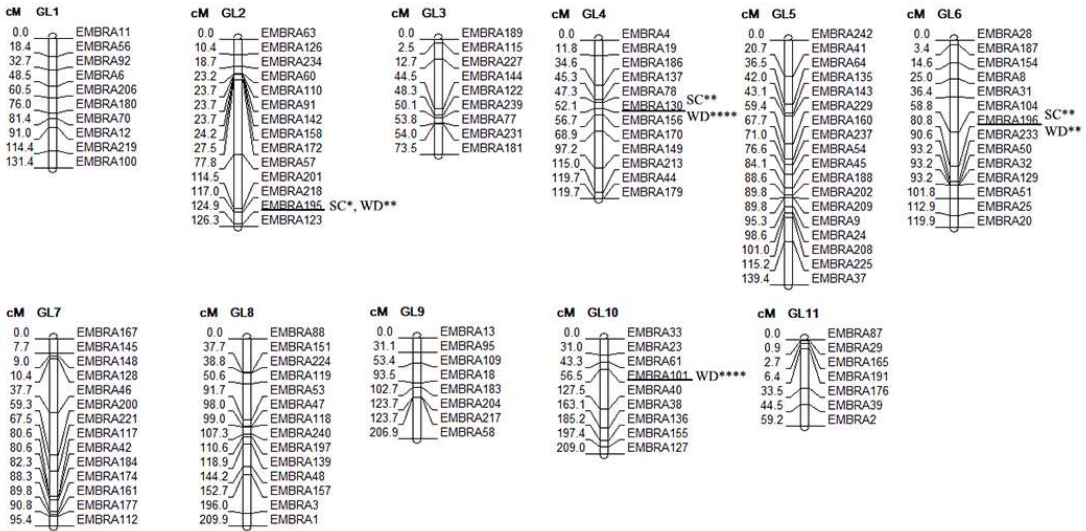
Figure 2. Loci associated with wood density (WD) and slenderness coefficient (SC) across the genome of E. cladocalyx (Bayesian multivariate mapping). To the left the distance in centiMorgan (cM) and to the right the name of the molecular markers (SSR, n = 130). LG: Linkage Group. * moderate evidence of association (3 < BF < 10); ** strong evidence of association (10 < BF < 30); ** very strong evidence of association (30 < BF < 100). **** extreme evidence of association (100 < BF). BF: Bayes Factor.